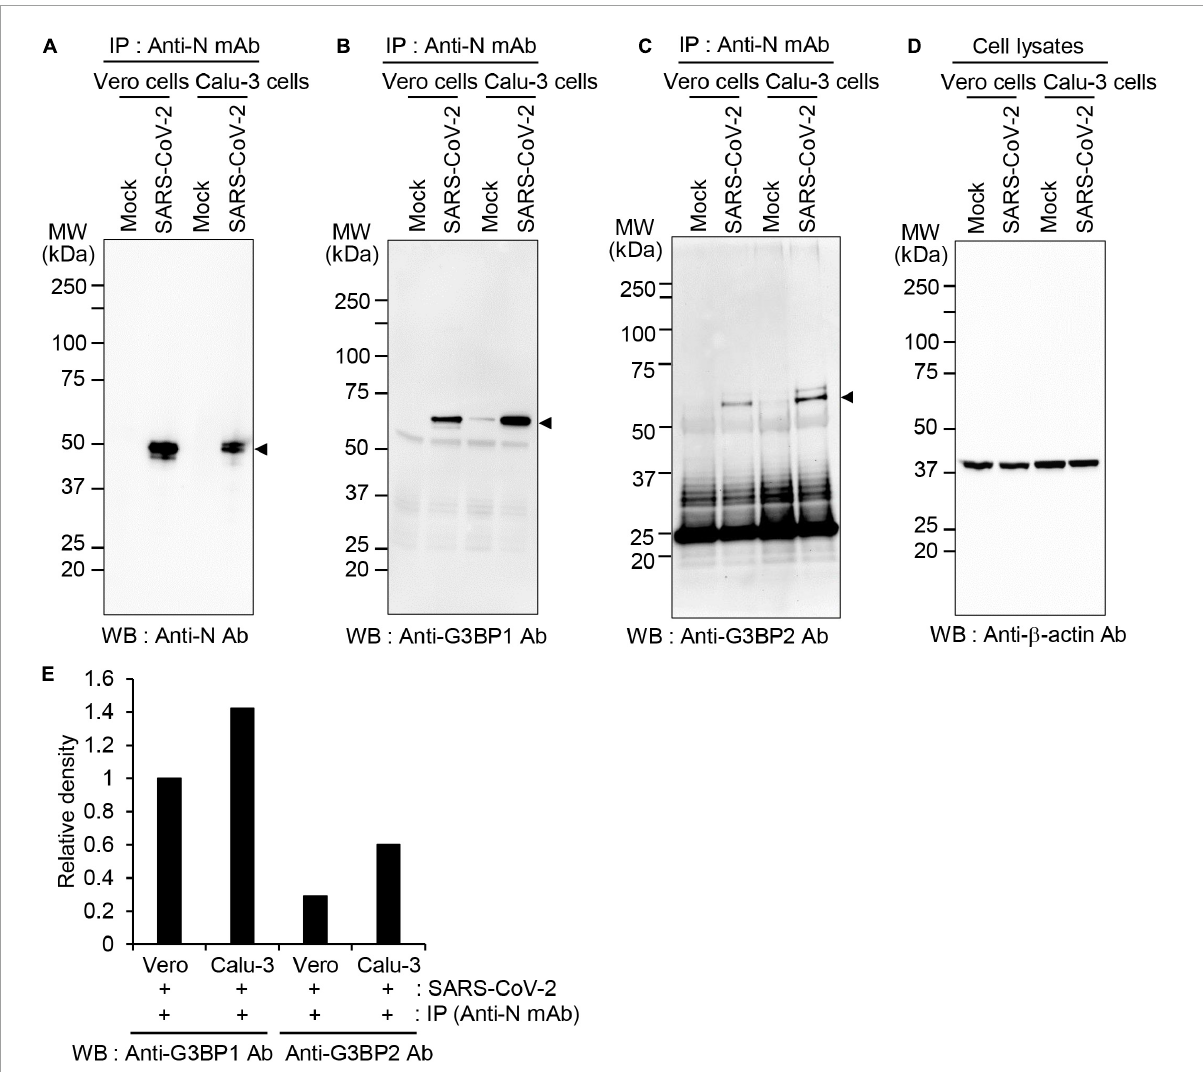
FIGURE2 Differential association between SARS-CoV-2 N protein and G3BP1/2 in Vero and Calu-3 cells (A–D) Vero and Calu-3 cells were mock-infected or infected with SARS-CoV-2 S clade at 0.1 MOI; cell lysates were immunoprecipitated with anti-SARS-CoV-2 N mAb and analyzed by western blot with anti-SARS-CoV-2 N Ab (A) , anti-G3BP1 antibody (B) , anti-G3BP2 antibody (C) , or anti- β -actin antibody, as the input control (D) . (E) The band intensities of G3BP1 and G3BP2 were normalized with those of β -actin and the relative band intensities of Co-IPed proteins are shown on the graph. Anti-N mAb, anti-SARS-CoV-2 N mAb (clone 1G10C4 mAb); Anti-N Ab, anti-SARS-CoV-2 N polyclonal